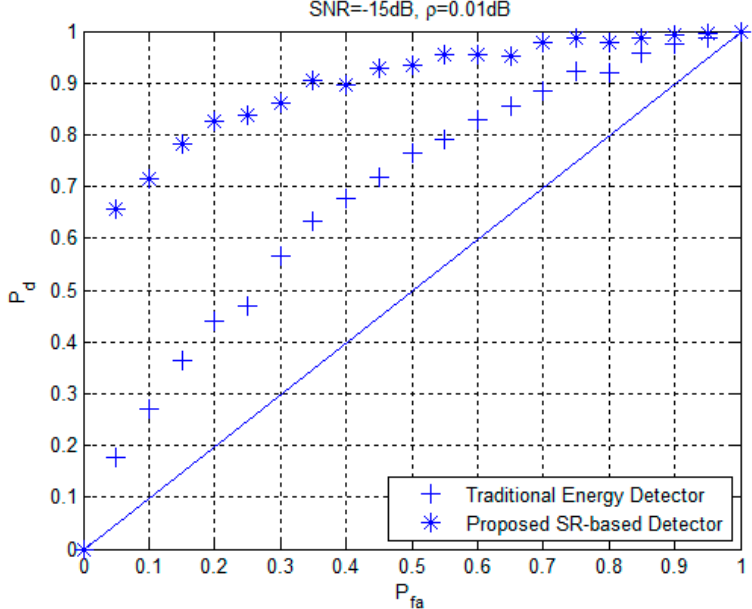
Figure 11. ROC curves of the proposed SR-based detection approach and the traditional energy detector under SNR = − 15 dB and ρ = 0.01 dB.